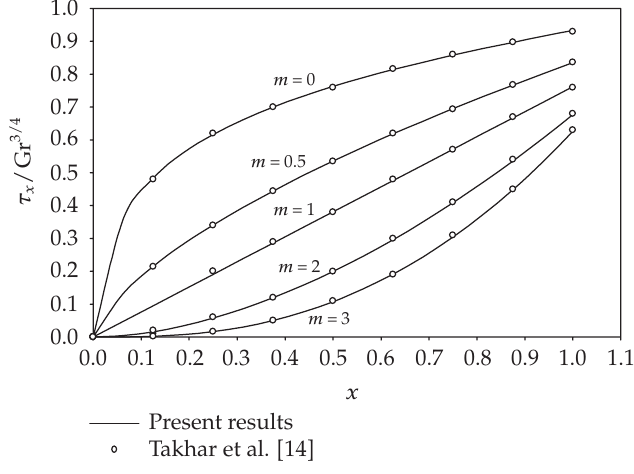
Figure 5.9 . Comparison of local skin